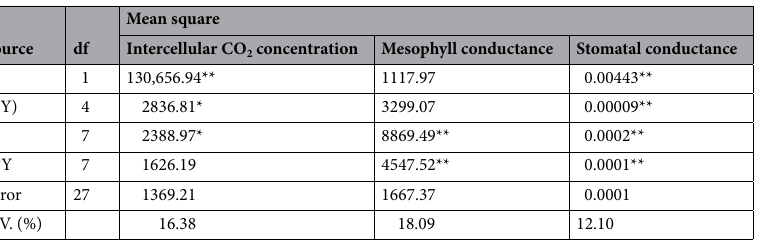
Table 3. Analysis of variance of application of plasma, pyroligneous acid, azolla compost and biochar on physiological responses of wheat. * p < 0.05, ** p < 0.01, Y, year; R(Y), replication year; T, treatments; T*Y, interaction between treatments and years; df, degree of freedom; C.V., coefficient of